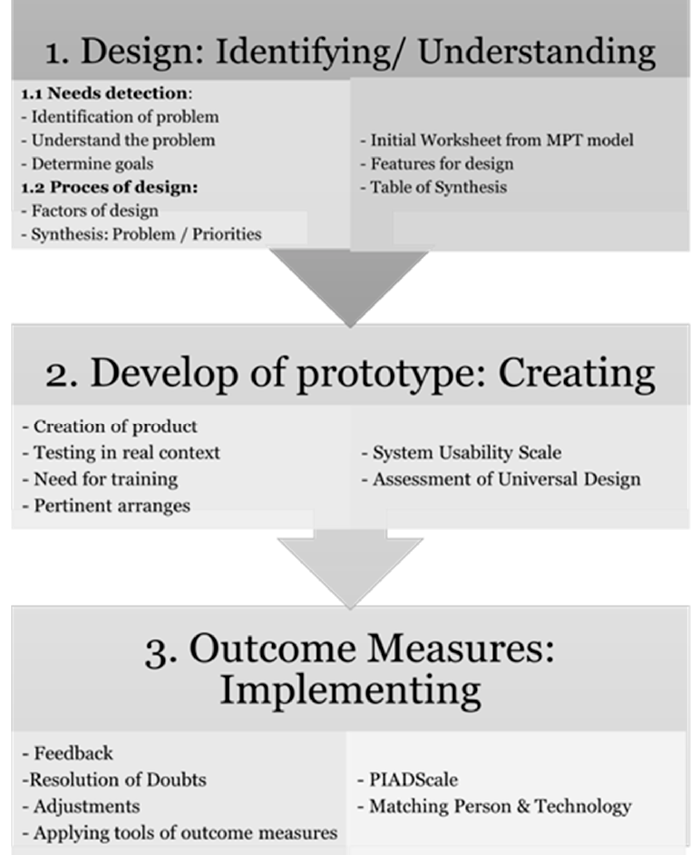
Figure 1. Global structure of the framework.